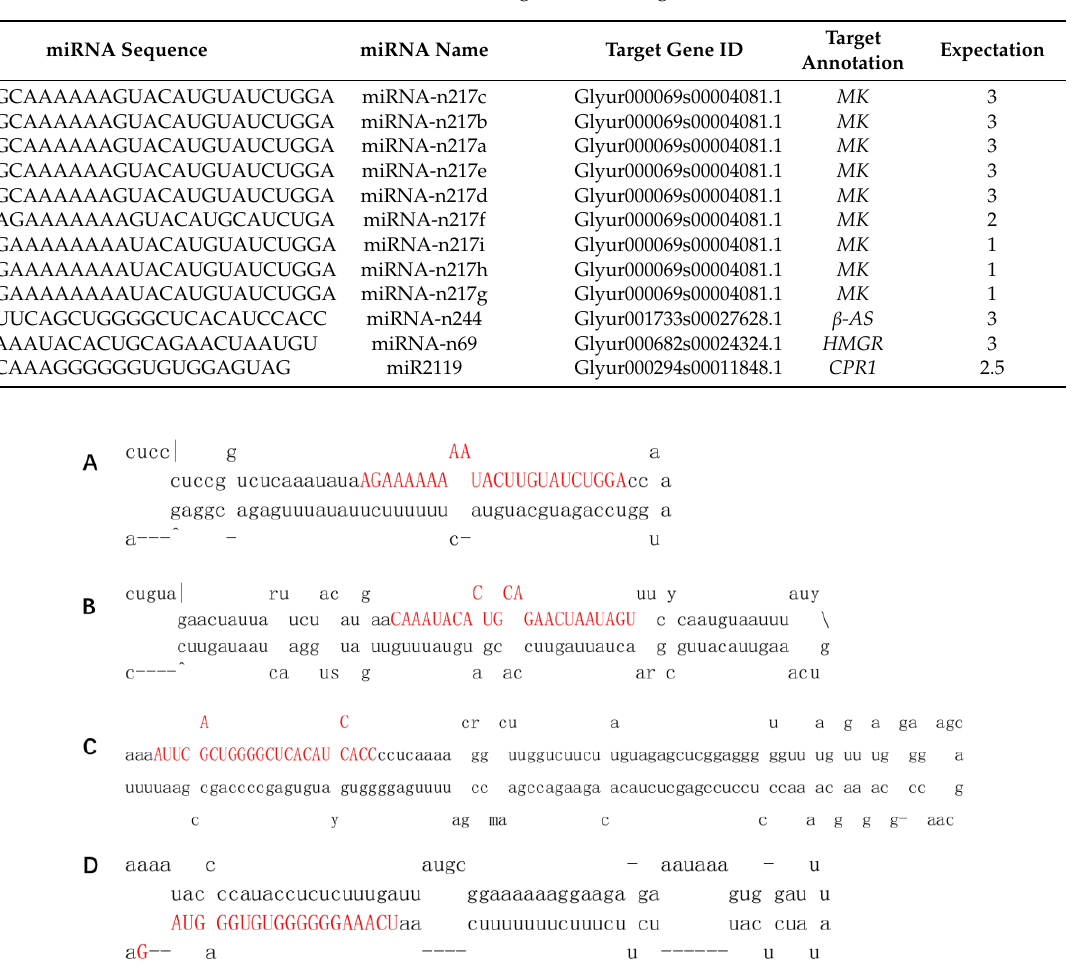
Table 4. miRNAs target structural genes.